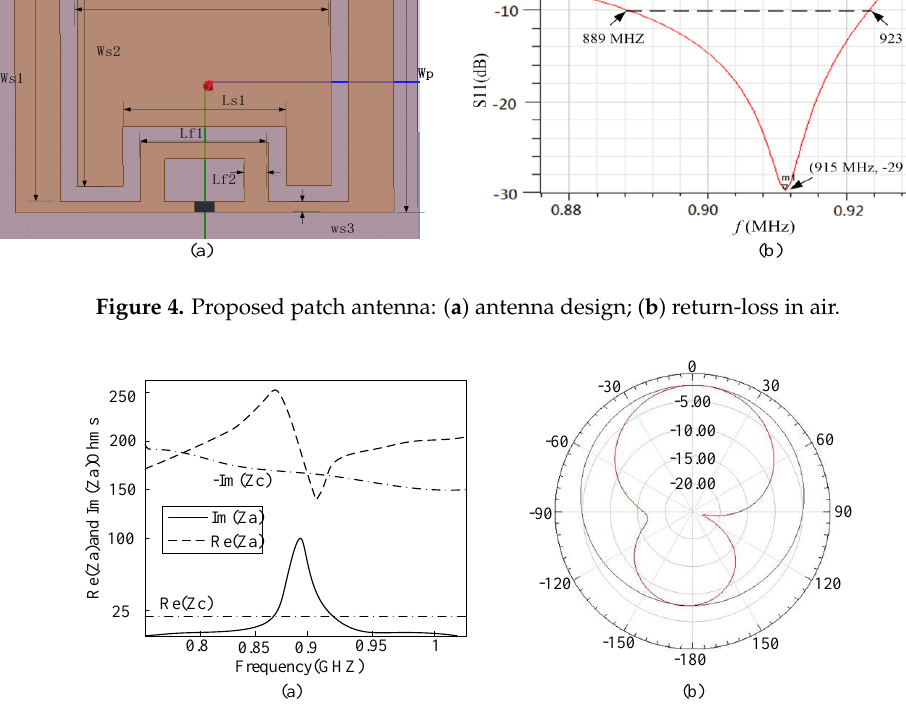
Figure 5. ( a ) Simulated impedance match between tag and antenna; ( b ) Simulated pattern radiation of the tag antenna.